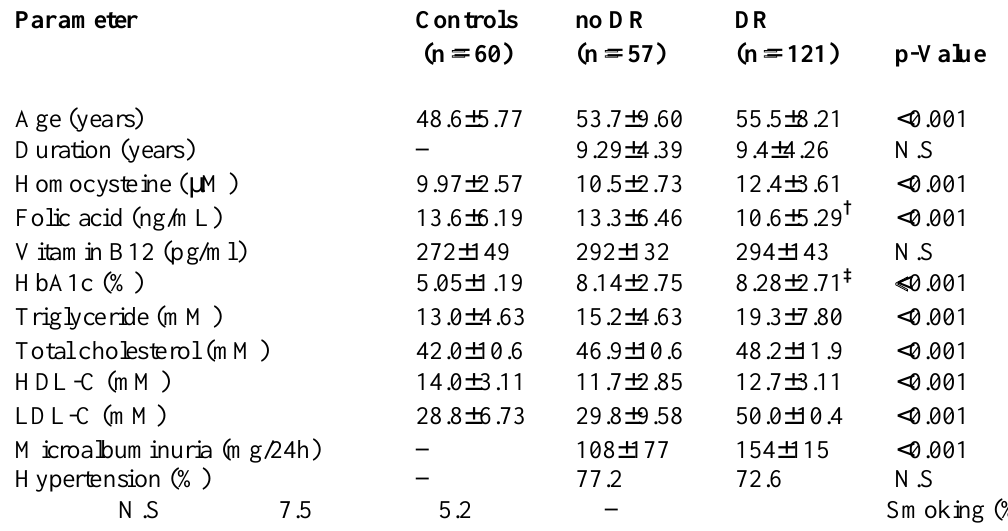
the colorimetric method (Beckman CX9 autoanalyser (USA) with Beckman Kits). Glycosylated hemoglobin (HbA1c), HDL cholesterol (HDL-C), LDL cholesterol Table 1.: Clinical and demographic profile of control and diabetes patients with or without retinopathy (DR). Values are mean – SD; N.S. not significant; †Significant compared to controls and no DR group (p < 0.001); ‡Significant compared to the control group (p < 0.001). HbA1c, glycosylated hemoglobin; HDL-C, high density lipoprotein cholesterol; LDL-C, Low lipoprotein